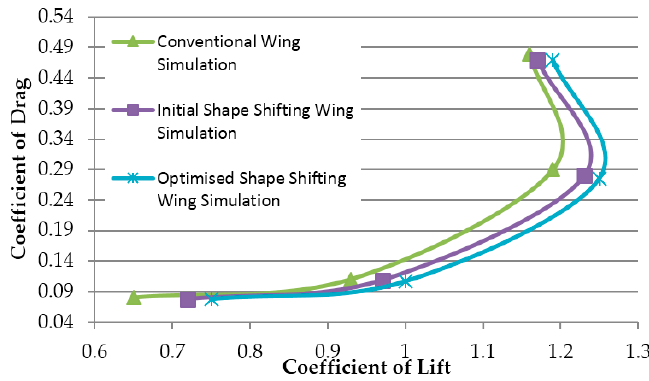
Figure 21. A graph showing the wing efficiency using coefficient of drag over coefficient of lift for each of the wings.